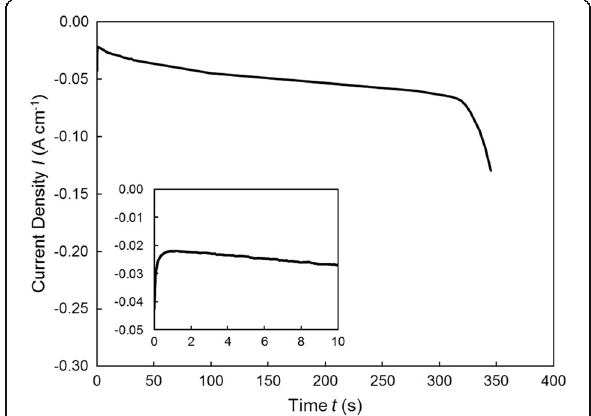
Fig. 3 Time-dependence of current density during Fe nanowire growth at − 1.2 V. The beginning of the deposition process is also shown in the inset